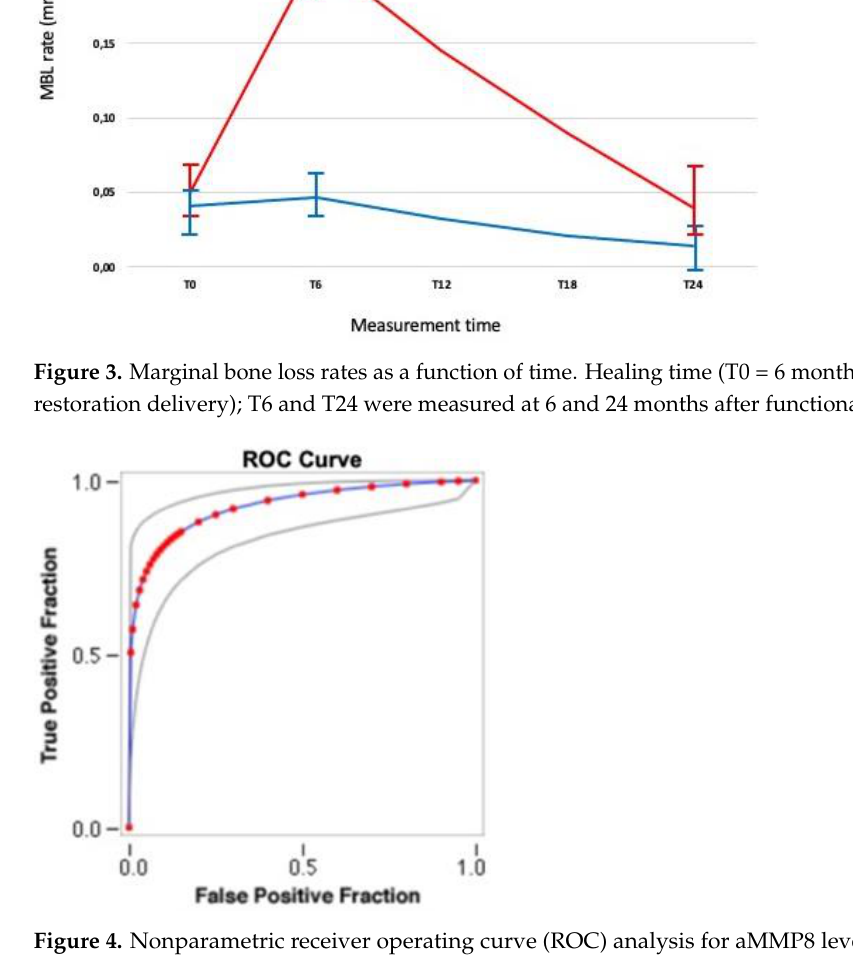
Figure 4. Nonparametric receiver operating curve (ROC) analysis for aMMP8 levels at 24 months. The areas under the ROC (AUC) are significant. Table 3. Mean rates, standard errors (), and median rates [] for factors explaining the variance in the dependent variables at the three measurements times (rates are expressed in mm/month).